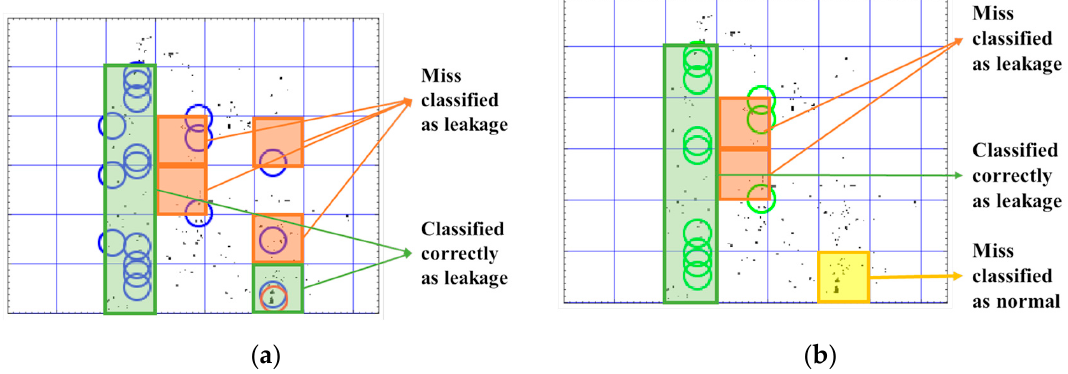
Figure 8. One sample frame in Video 7. ( a ) Particle filter can detect the one small leakage at the bottom of the frame. However, it has more misclassifications due to tracking the noise as well. ( b ) Proposed multi Kalman filter method has less misclassification and is more robust to the noise. However, it is missing one single drop at the bottom of the frame.